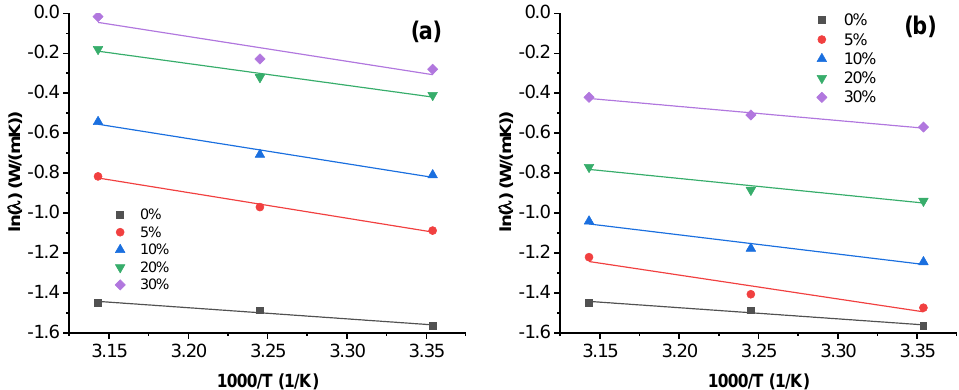
Figure 5. Arrhenius plots of thermal conductivity dependence on temperature for ( a ) MWCNT composites and ( b ) GN composites. Table 2. Parameters of the Arrhenius equation for PBSA composites.